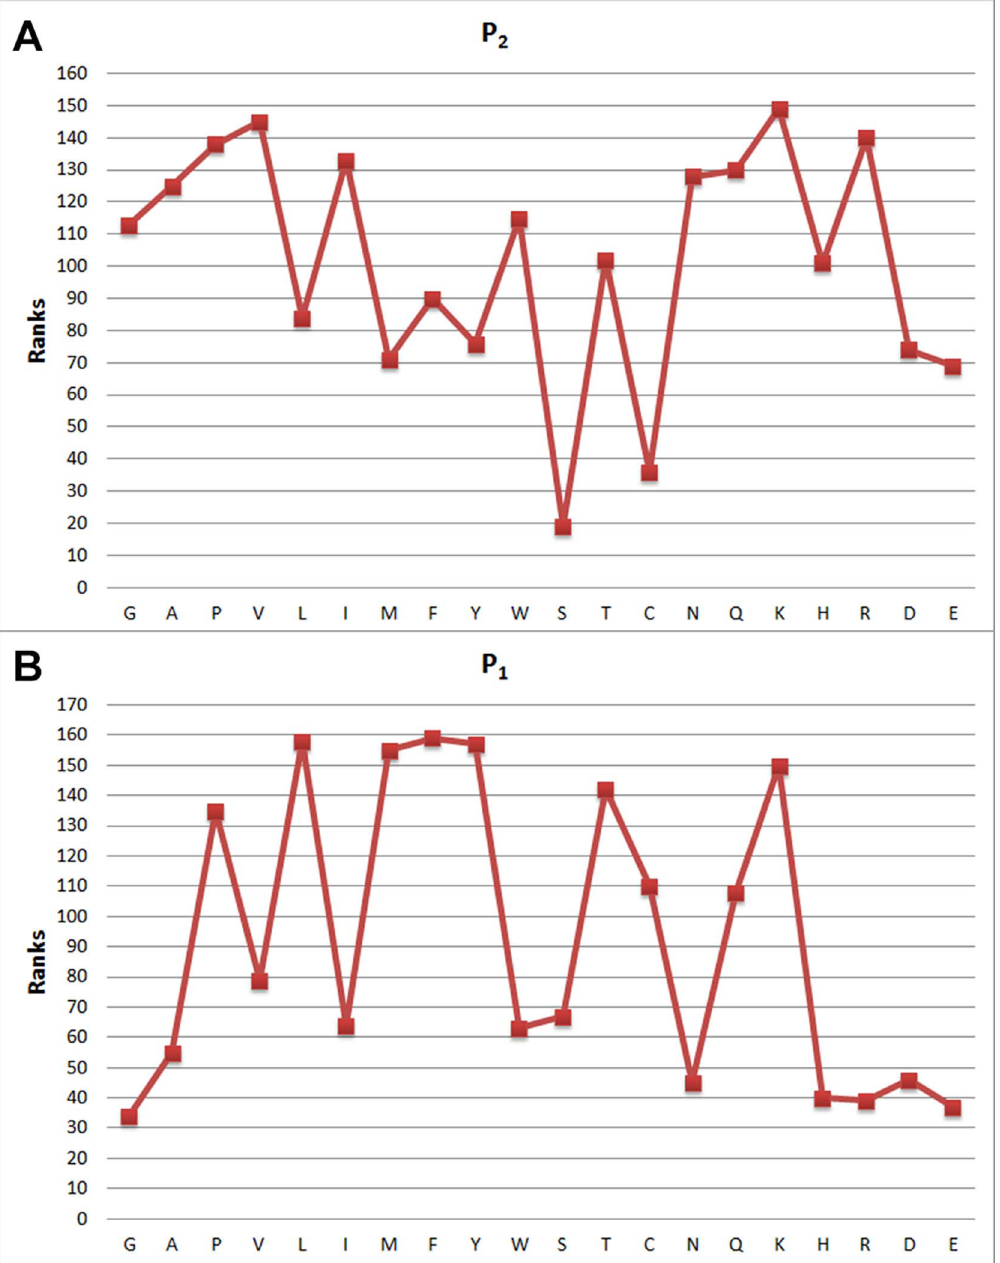
Figure 5. Feature weights of (a) P 2 and (b) P 1 attribute values with respect to indices and the distribution of attribute weights.